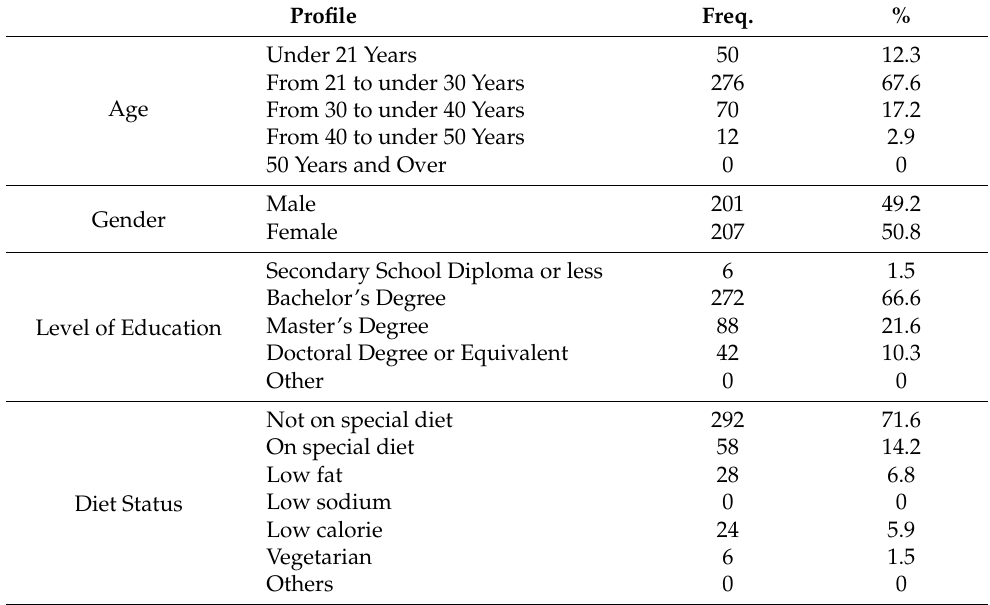
Table 1. The respondent profile.